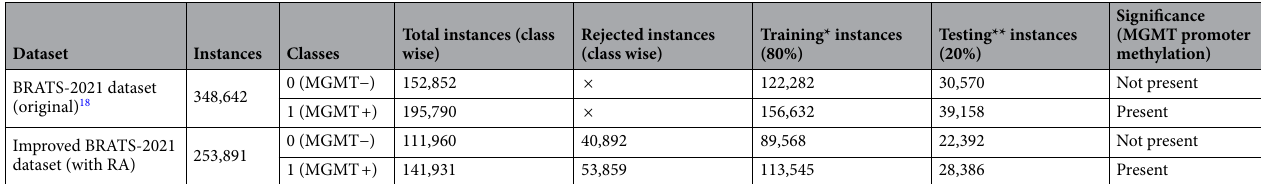
Table 2. Statistics of RSNA-MICCAI Brain Tumor Radiogenomic Classification dataset (with and without RA). *Total Training Instances (Original dataset): 278,914. Total Training Instances (Improved dataset):